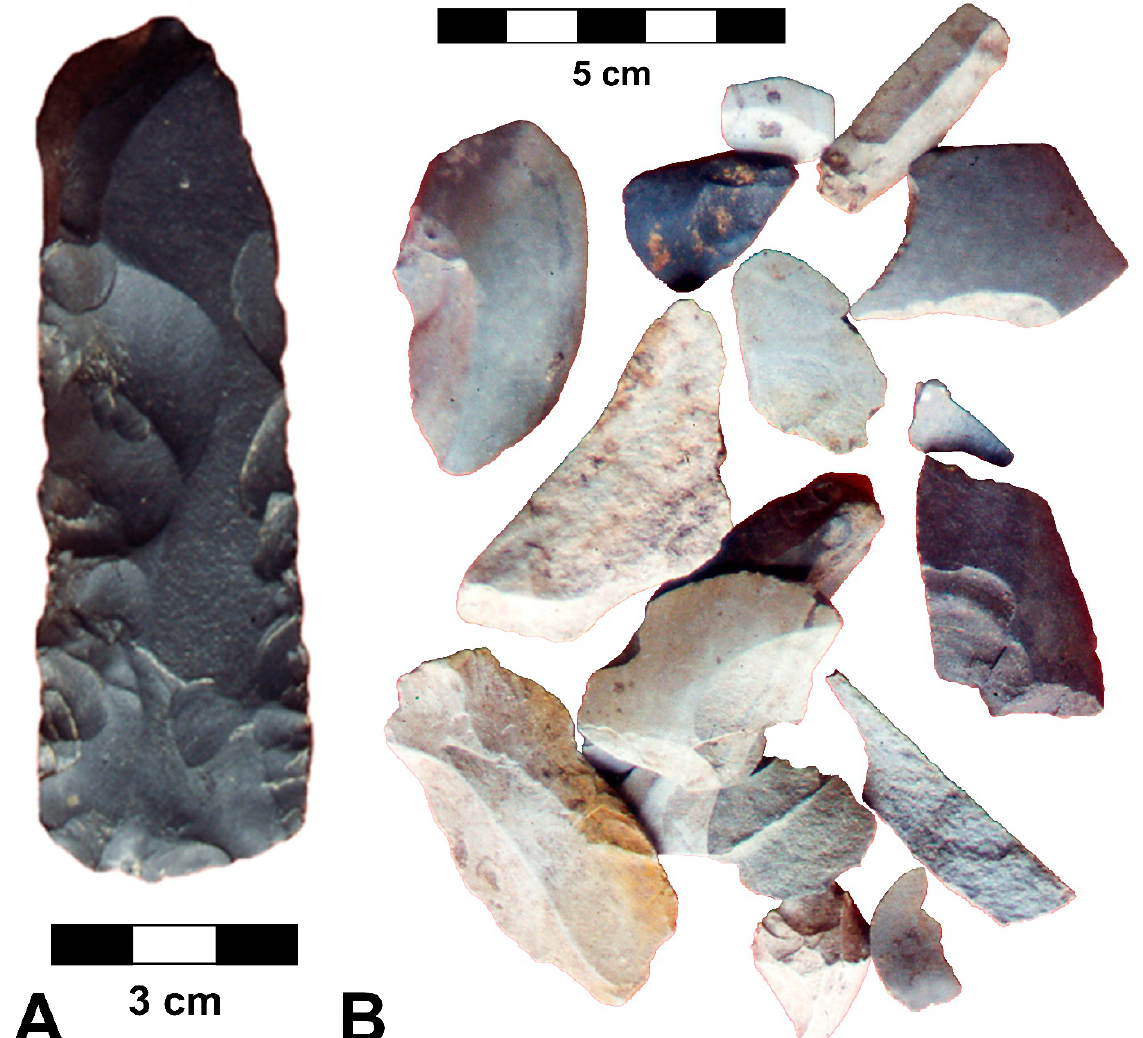
Figure 2. Méhtelek-Nádas, early Neolithic, Körös Culture: reworked polished stone tool by bifacial flaking (A); flakes from reworking polished stone tools; (B), scale in